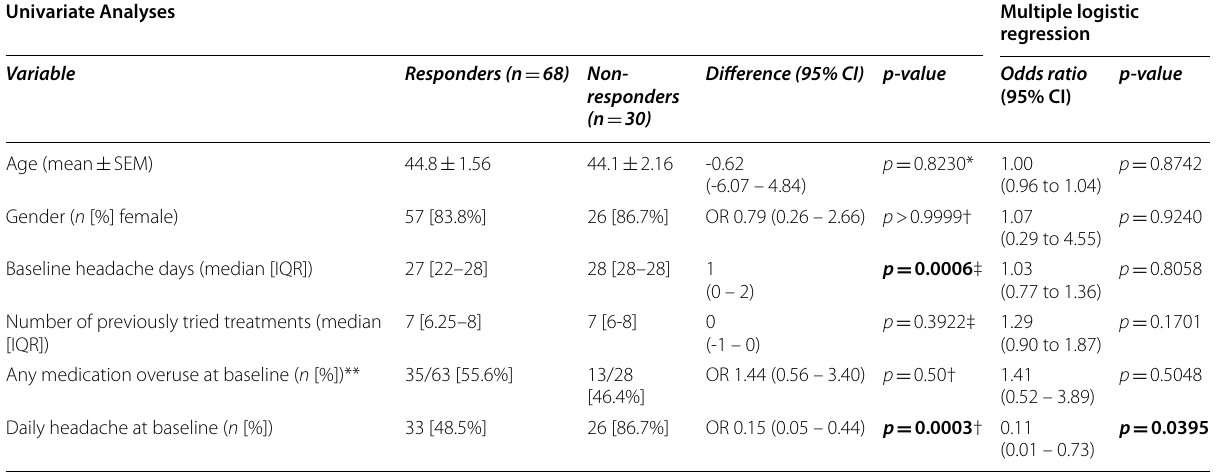
Table 2 Univariate analyses & multiple logistic regression comparing baseline characteristics between responders and non- responders